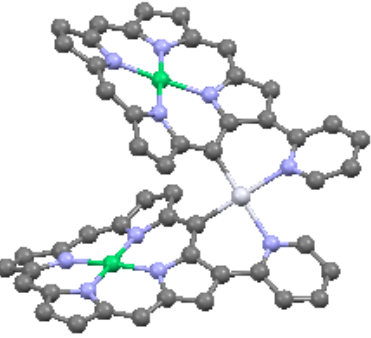
Figure 24. Pt (II)-linked Ni-porphyrin dimer, from data in [7,60]. Green = Ni, white = Pt.